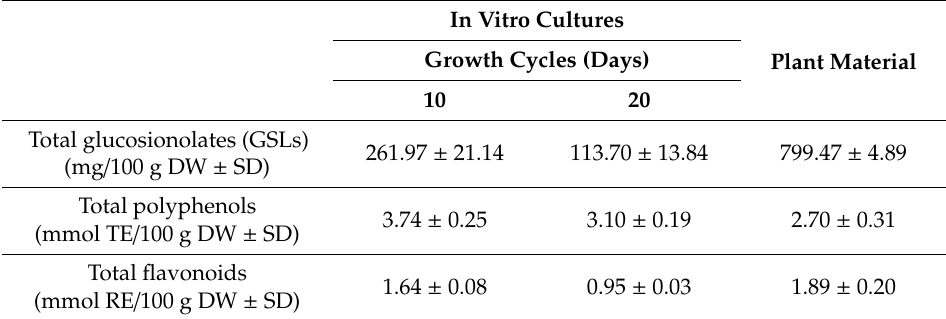
Table 1. Total GSLs, polyphenols and flavonoids contents in N. o ffi cinale extracts from bioreactor microshoot cultures and the herb of the parent